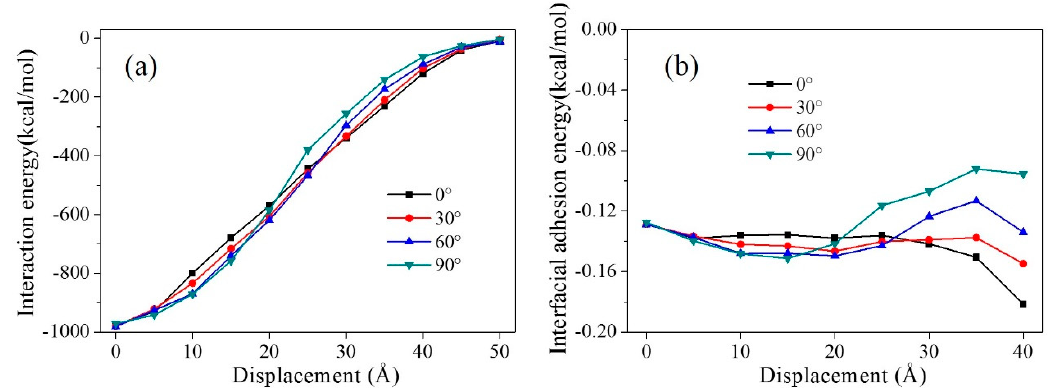
Figure 10. Interaction energies and interfacial adhesion energies for composite models with different angles between the CNT axial direction and pullout direction during the pullout process.